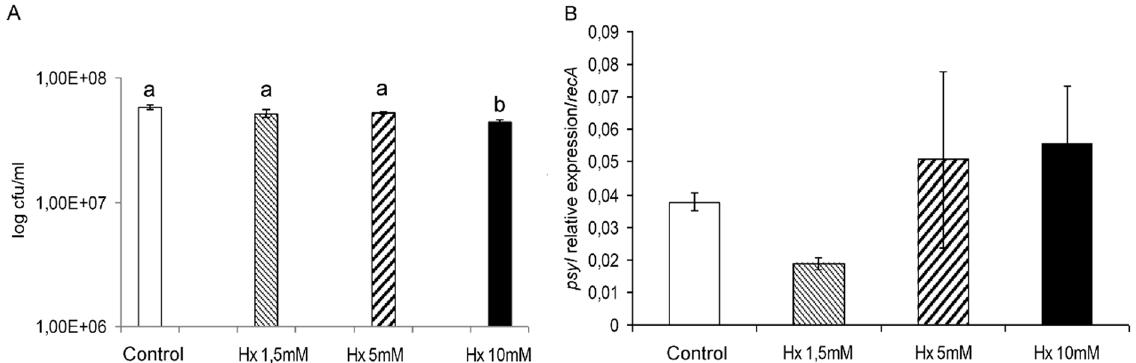
Figure 3. Effect of Hx on bacterial growth and QS-related genes. The bacteria were grown in LB medium and LB plus Hx at 1.5, 5, and 10 mM for 18 h and then plated on KB agar plates to count the colony forming units (A). The transcript levels of psyI were determined by qRT-PCR. The relative expression levels of psyI were normalized to those of recA (B). The results represent the means and standard deviations from three different